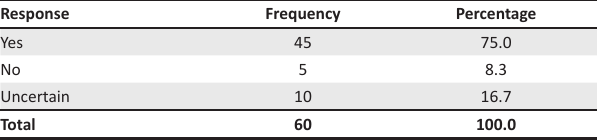
TABLE 4: Participants resposne to the fact that the reward management system encourage staff retention. Response